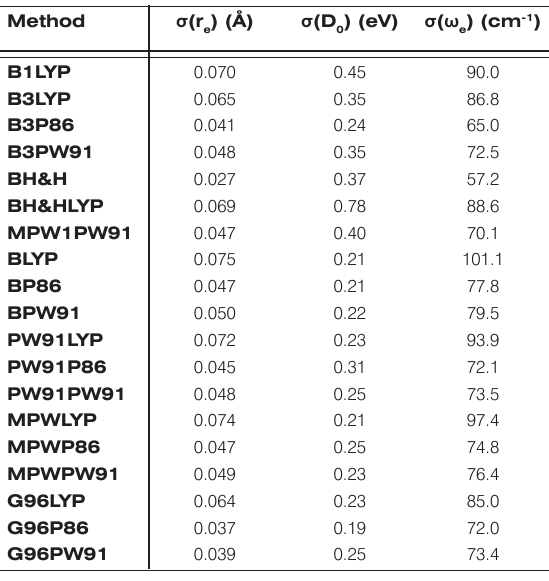
Table 1. The diatomic properties calculated by means of the hybrid (the first seven rows) and non-local (the next twelve rows) functionals